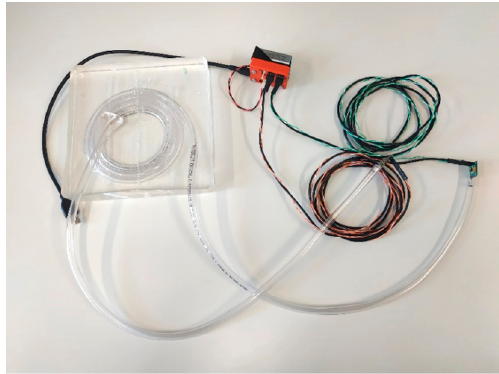
Figure 6. The low-cost acoustic measurement kit.